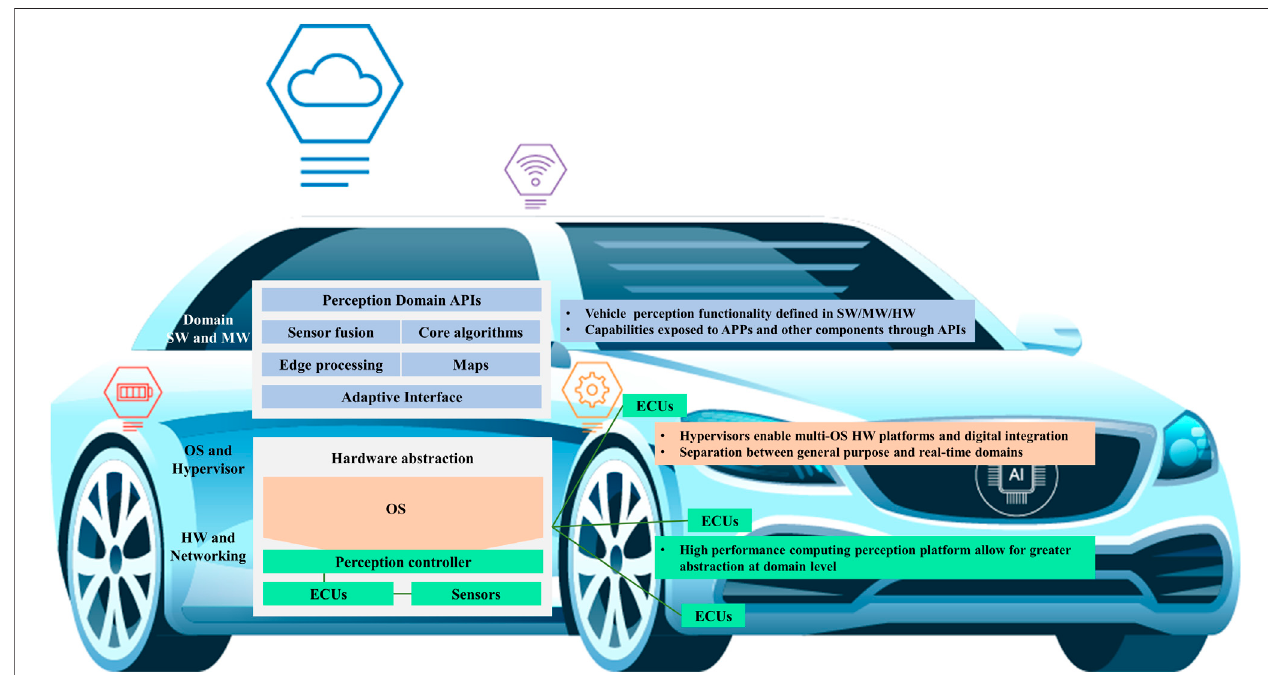
FIGURE 12 | Hardware and software partitioning in ECAS